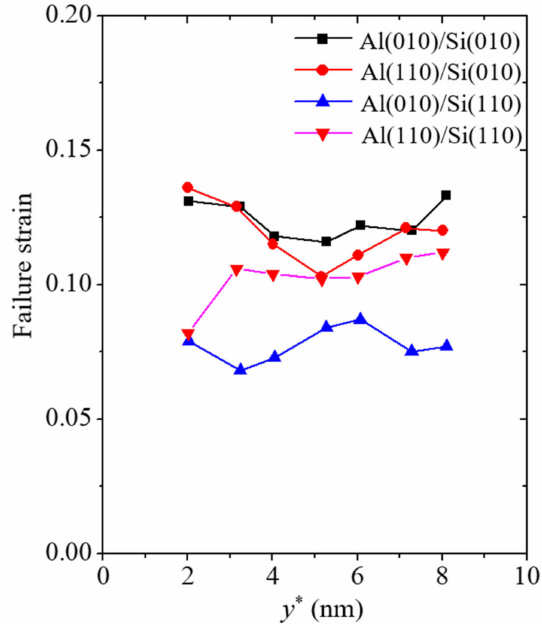
Figure 7. Failure strain corresponding to the varying thicknesses of Al nanofilm denoted by the variable y